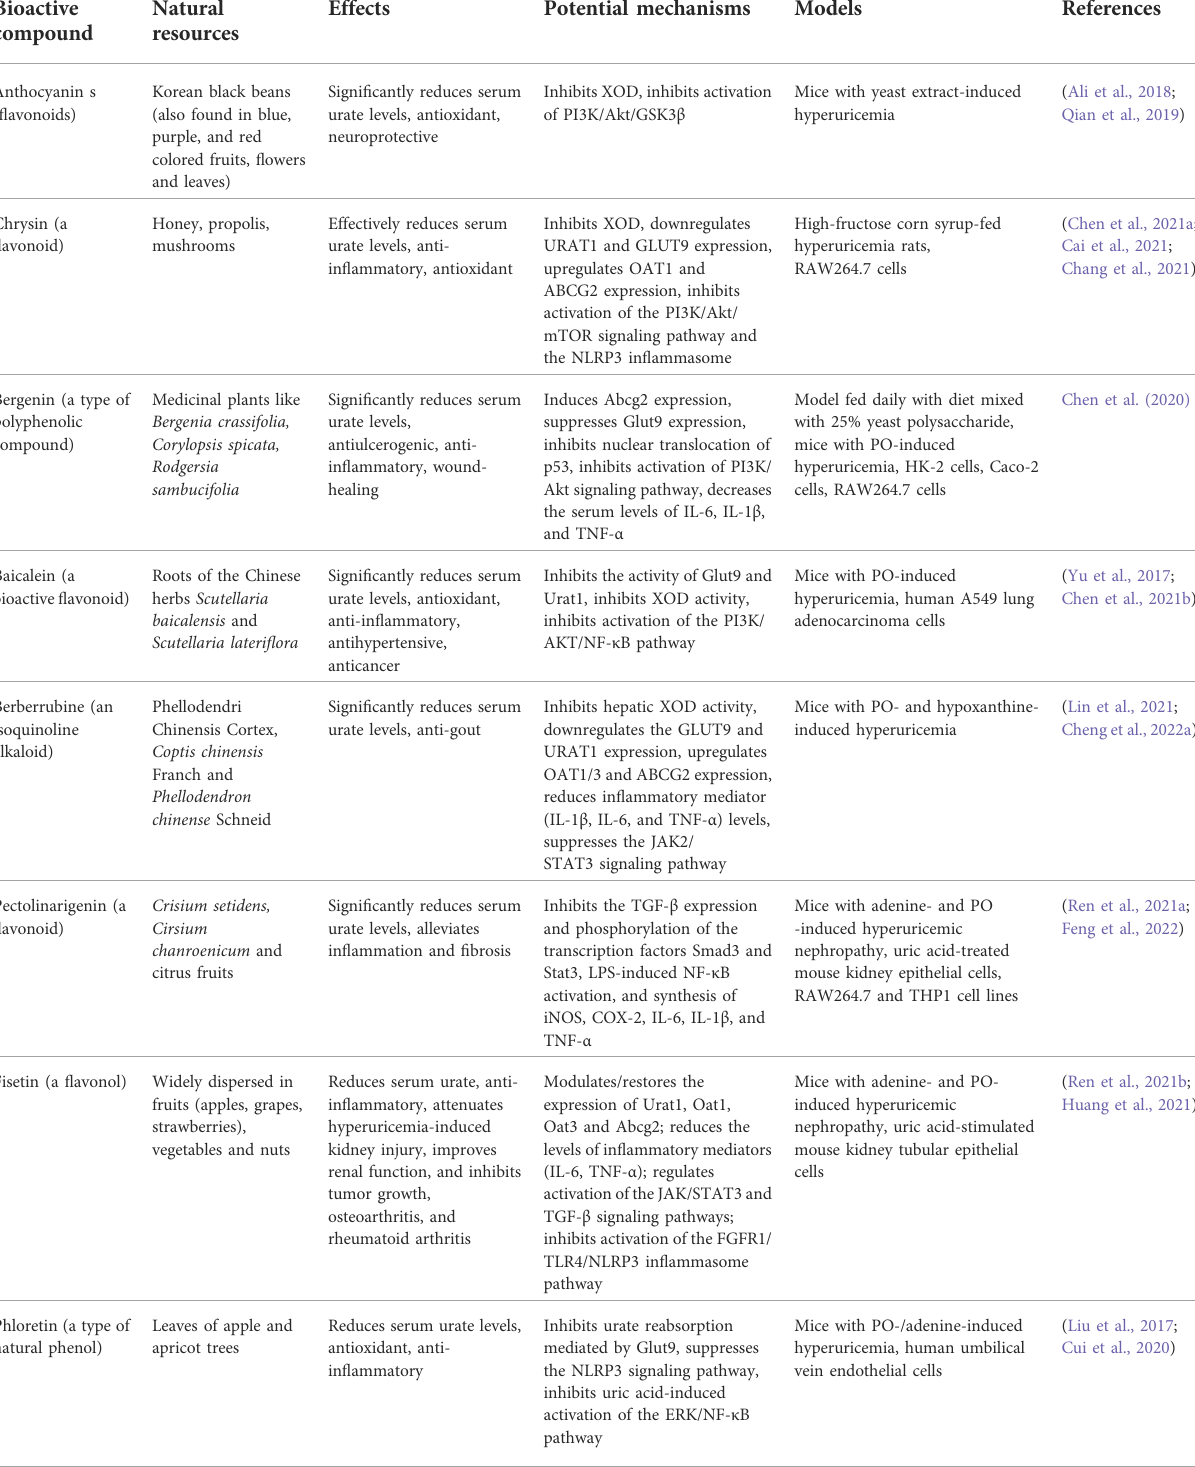
TABLE 1 Summary of the effects and potential mechanisms of candidates for hyperuricemia treatment. PO, potassium oxonate; LPS, lipopolysaccharide; URAT1, human urate transporter 1; GLUT9, glucose transporter member 9; ABCG2, ATP-binding cassette transporter, subfamily G, member 2; OAT, organic anion transporter; NPT, sodium-dependent phosphate cotransporter type; NLRP3, NOD-like receptor family pyrin domain-containing 3; IL-6, interleukin-6; IL-1 β , interleukin-1 β ; NF- κ B, nuclear factor-kappa B; TGF- β , transforming growth factor-beta;